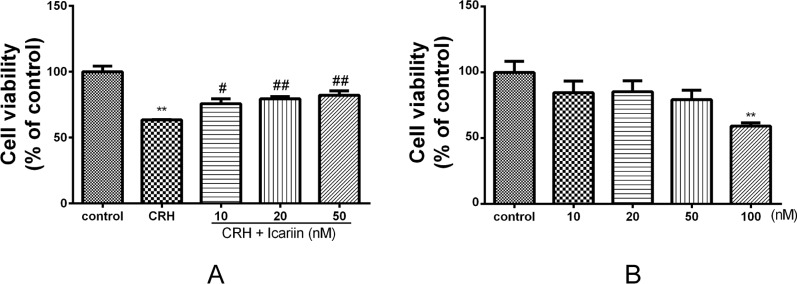
Effects of CRH and icariin on the activity of primary cultured rat hippocampal neurons with MTT assay. Primary cultured rat hippocampal neurons were pretreated with different concentrations of icariin (10, 20, or 50 nM) for 2 h followed by treatment of 5 nM CRH for 24 h (A). Primary cultured rat hippocampal neurons were treated with 10–100 nM of icariin, the activity of which were tested with MTT assay (B). **p < 0.01 vs. control; #
p < 0.05 and ##
p < 0.01 vs. CRH.